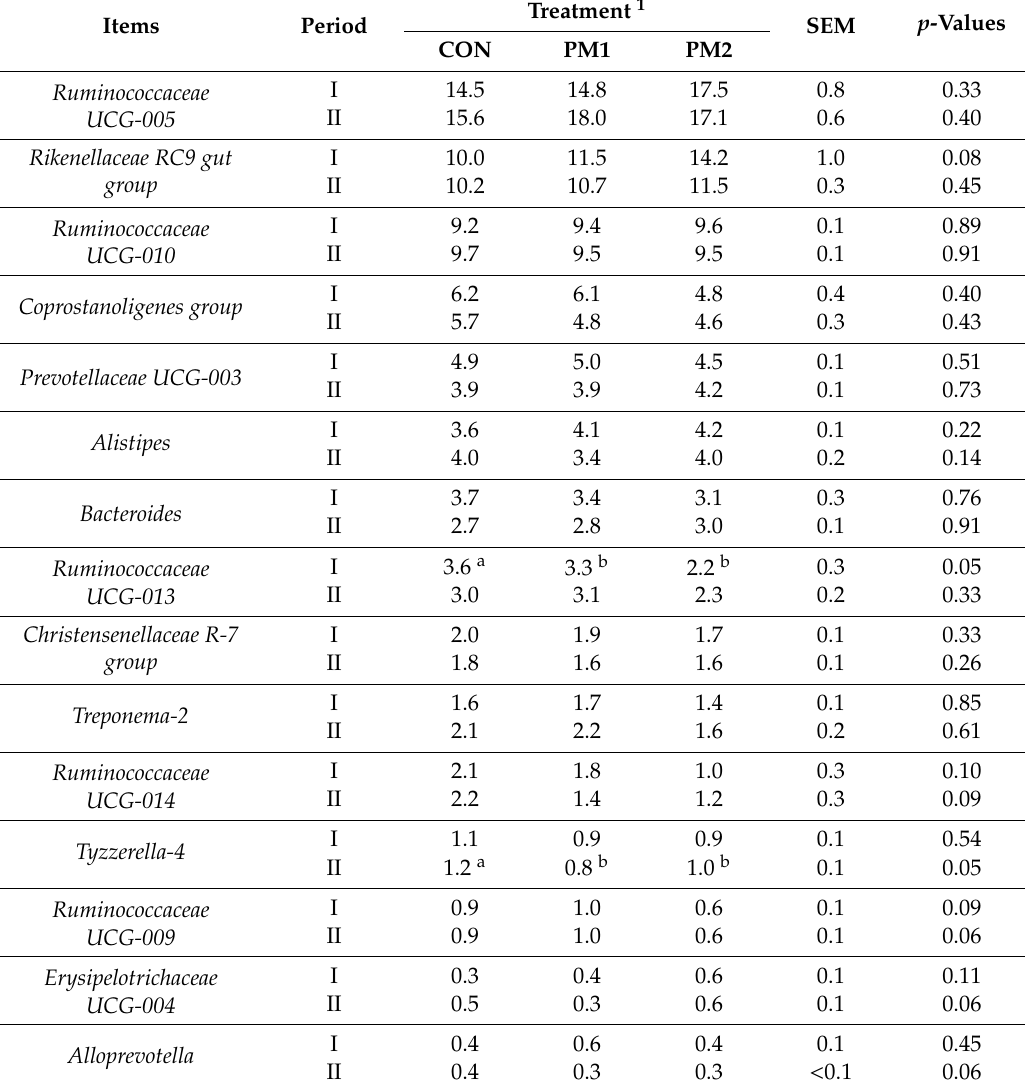
Table 4. E ff ects of paper mulberry silage on the fecal bacteria composition at the genus level (top fifteen). Treatment 1 Items Period